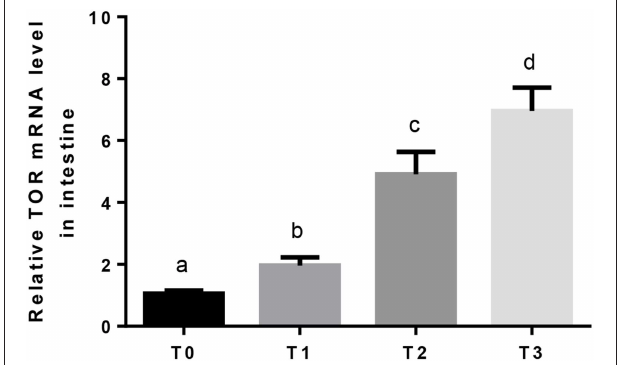
FIGURE 1 | The relative expression of TOR mRNA in the intestine. The letters indicate the results of multiple range test, the different letters indicated significant differences ( P <